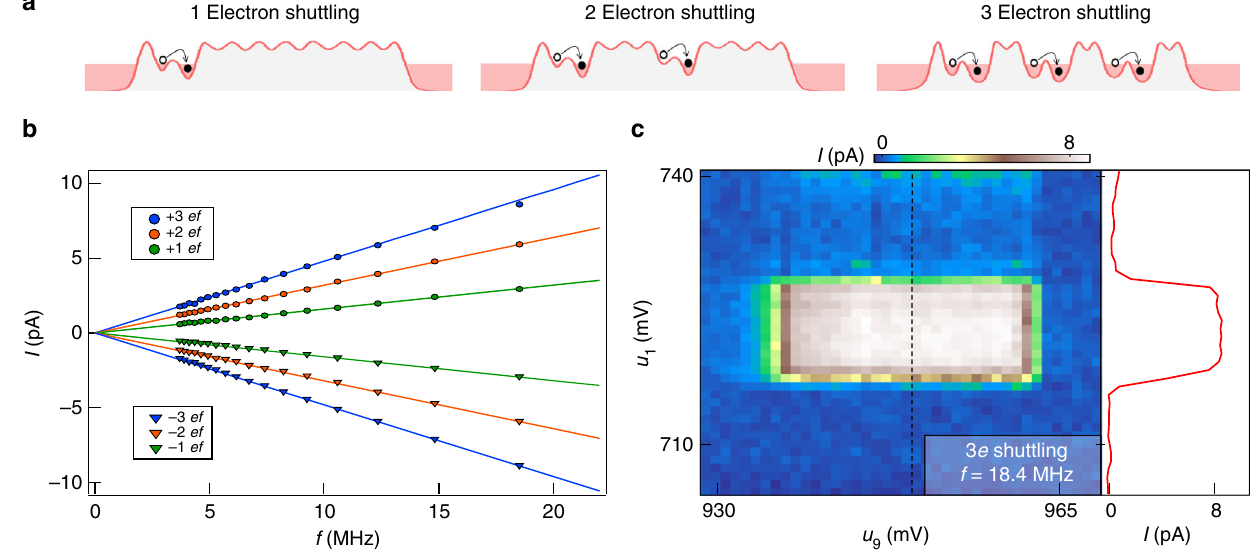
Fig. 4 9-dot charge shuttling. a Examples of single, double, and triple electron charge shuttling sequences. b Current I measured as a function of frequency f for single, double, and triple electron charge shuttling in both the forward and reverse directions. For reference, the solid line shows the expected current I = nef for − 3 ≤ n ≤ 3. c I measured as a function of u u 1 and 9 during continuous 3-electron charge shuttling. A robust region of pumped current is observed. Right panel: a line-cut through the data shows a stable plateau of pumped current 4 NATURE COMMUNICATIONS| (2019) 10:1063